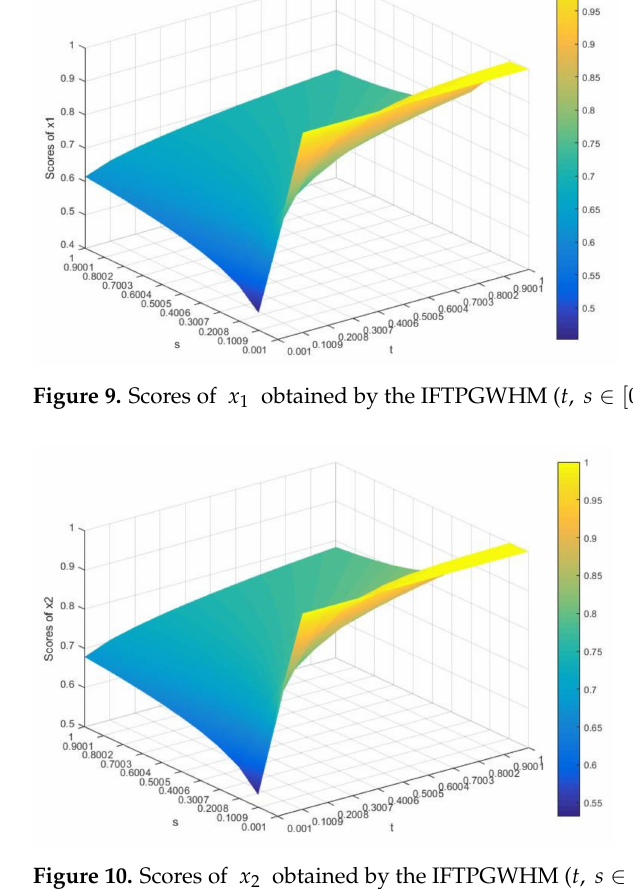
Figure 10. Scores of x 2 obtained by the IFTPGWHM ( t , s ∈ [ 0.001,1 ] ).